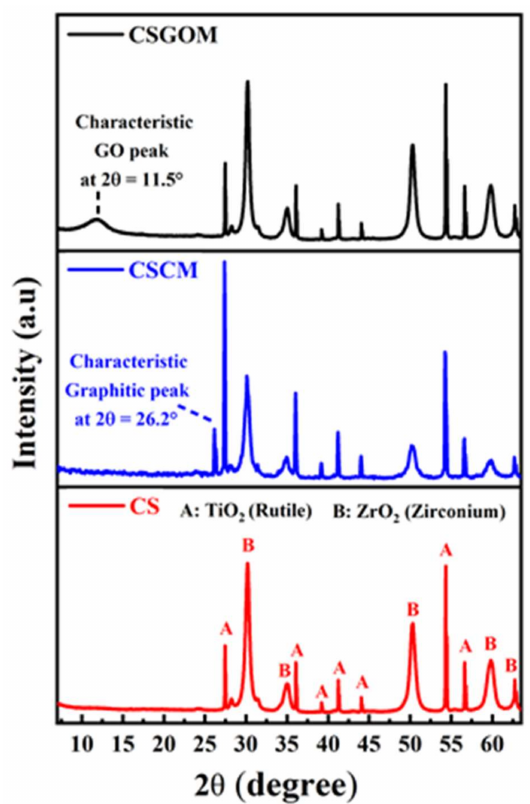
Figure 3. X-ray diffractogram of the ceramic support (CS) and the ceramic-supported carbon-based membrane (CSCM: 10% wt. Matrimid and CSGOM: 1 mg · L − 1 GO